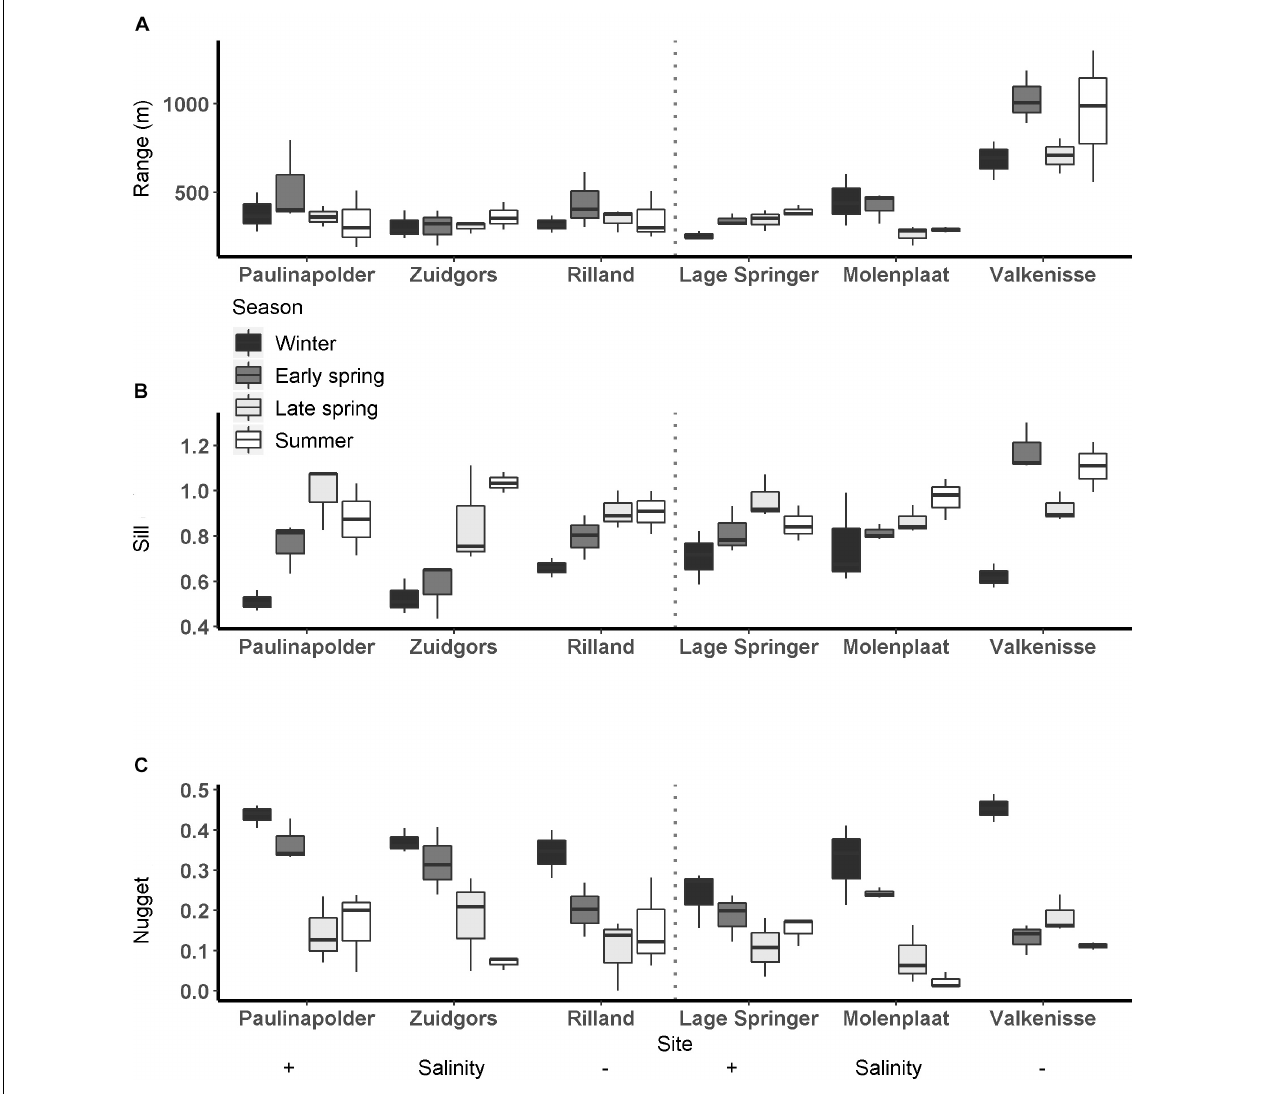
FIGURE 4 | Semi-variogram parameters per season per site at fringing (left) and mid-channel (right) tidal flats ( A : range (m), B : sill, C :